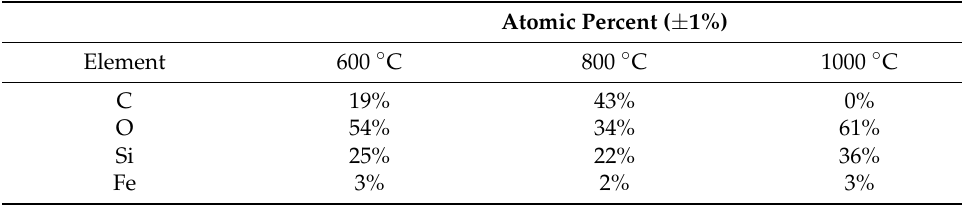
Figure 5. SEM images of layers sintered at ( a ) 600 °C ( b ) 800 °C ( c ) 1000 °C. Table 1. Results of EDS of samples sintered at 600, 800, and 1000 ◦